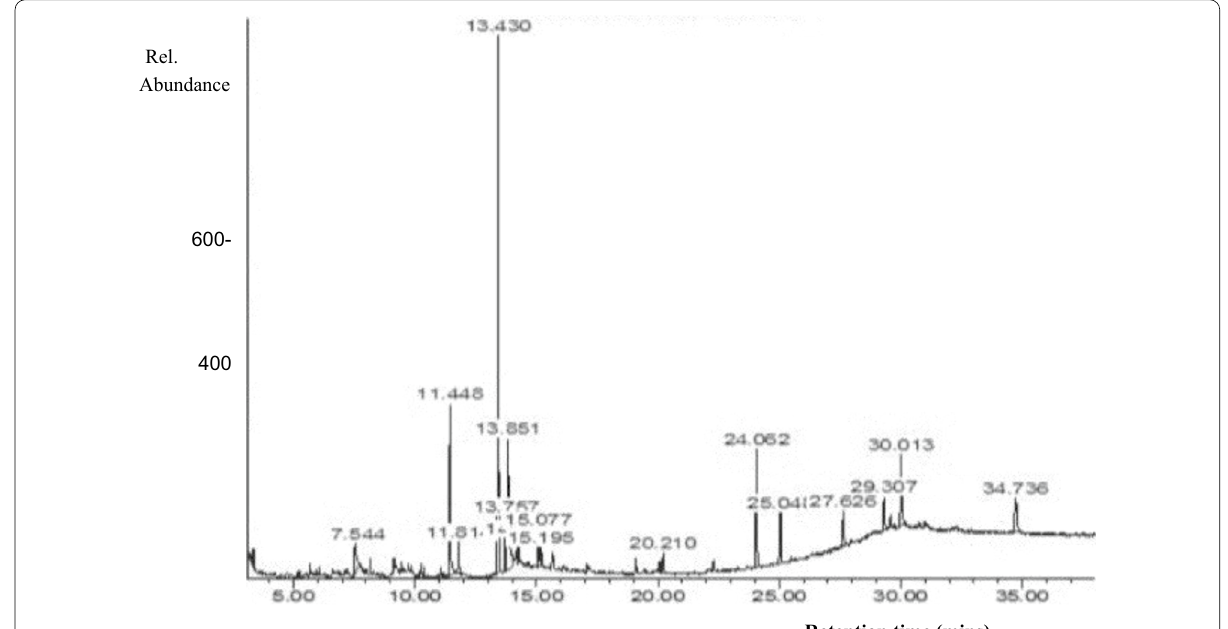
Fig. 1 Bioactive compounds in aqueous extract of Vernonia amygdalina leaf